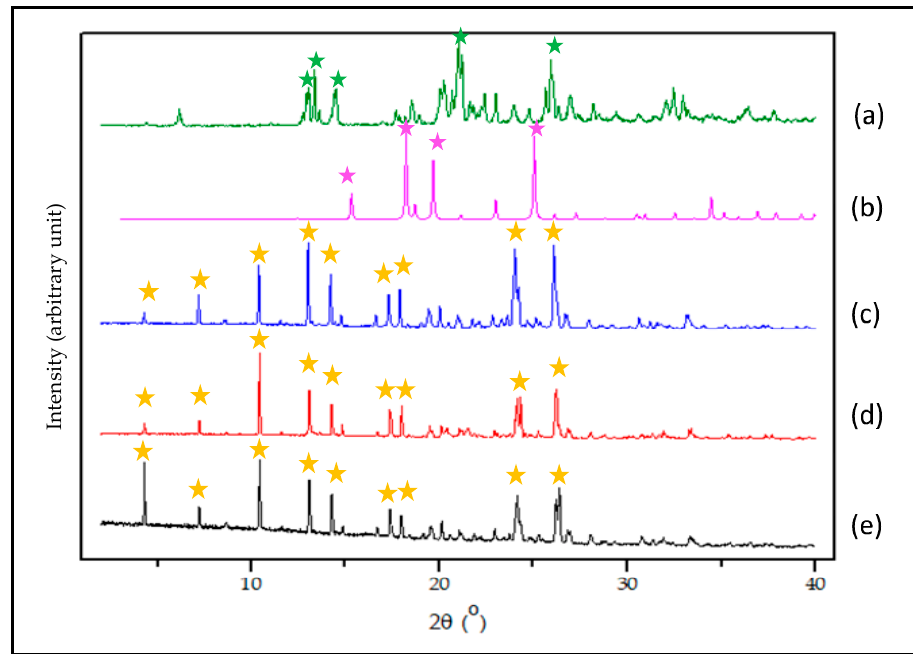
Figure 5. Diffractogram of NDH ( a ); LP ( b ); and NDPT from the 95% of methanol ( c ), acetone ( d ), and ethanol ( e ). The distinctive peaks of the new phase are assigned with yellow mark.